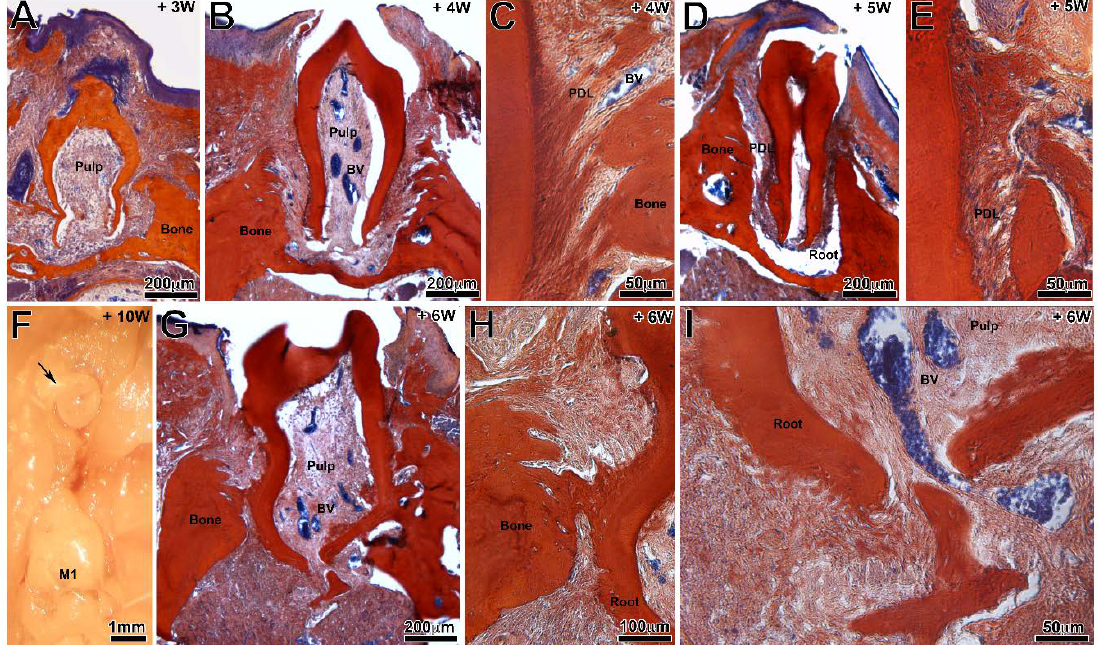
Figure 2. Histological sections of bioengineered teeth implanted with ( B , C , E , F , G – I ) or without a PCL membrane ( A , D ) at 3 ( A ), 4 ( B , C ), 5 ( D , E ) and 6 ( G – I ) postoperative weeks (Mallory staining). ( F ) Binocular observation of bioengineered tooth eruption after 10 weeks of implantation. BV = blood vessel, PDL = periodontal ligament.